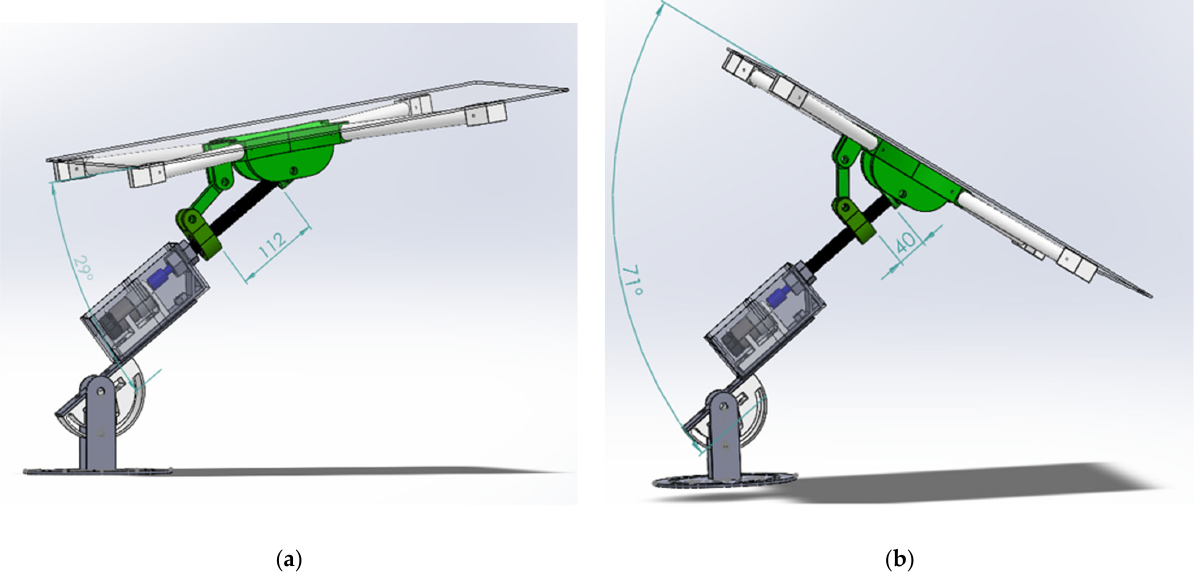
Figure 4. Orientation of the heliostat primary mirror for two positions, ( a ) and ( b ), differing by 40 complete system revolutions.